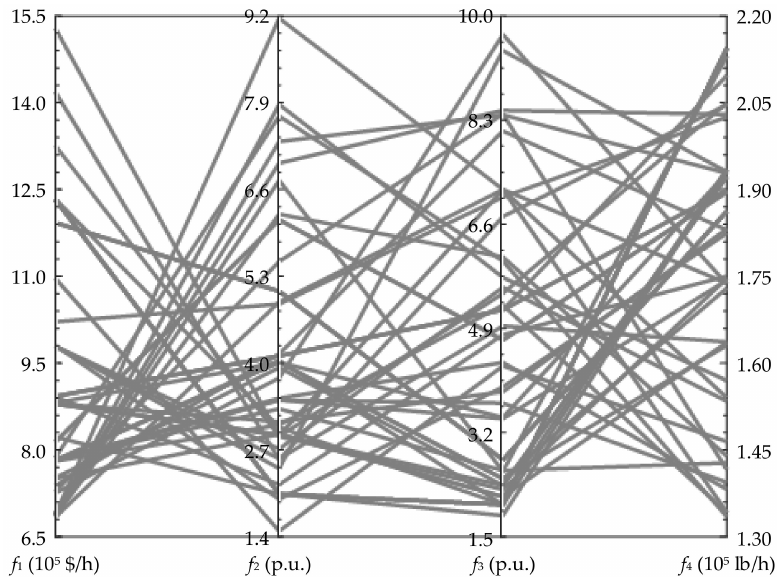
Figure 6. Distribute condition of solutions of the Hebei provincial system.